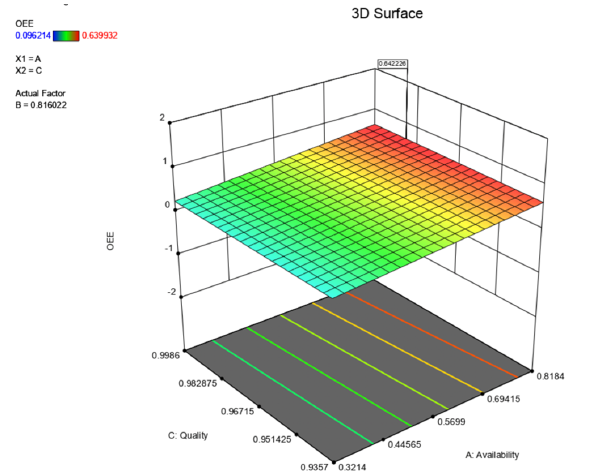
Fig. 13. 3D Response surface plot – Quality vs